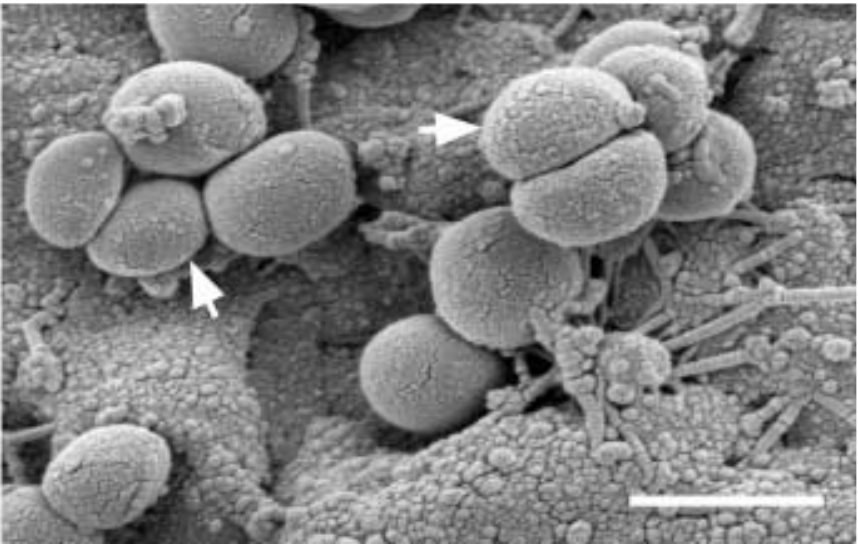
Staphylococcus au- reusbiofilm causing prosthetic joint infec- tion. Arrows indicate bacterial cells at- tached to metal sur- face, arranged in complex three-di- mensional structures. The extracellular ma- trix was distorted by dehydration proce- dure during speci- men preparation for scanning electron microscopy (magnifi- cation, 25,000x; scale bar, 1 m m).